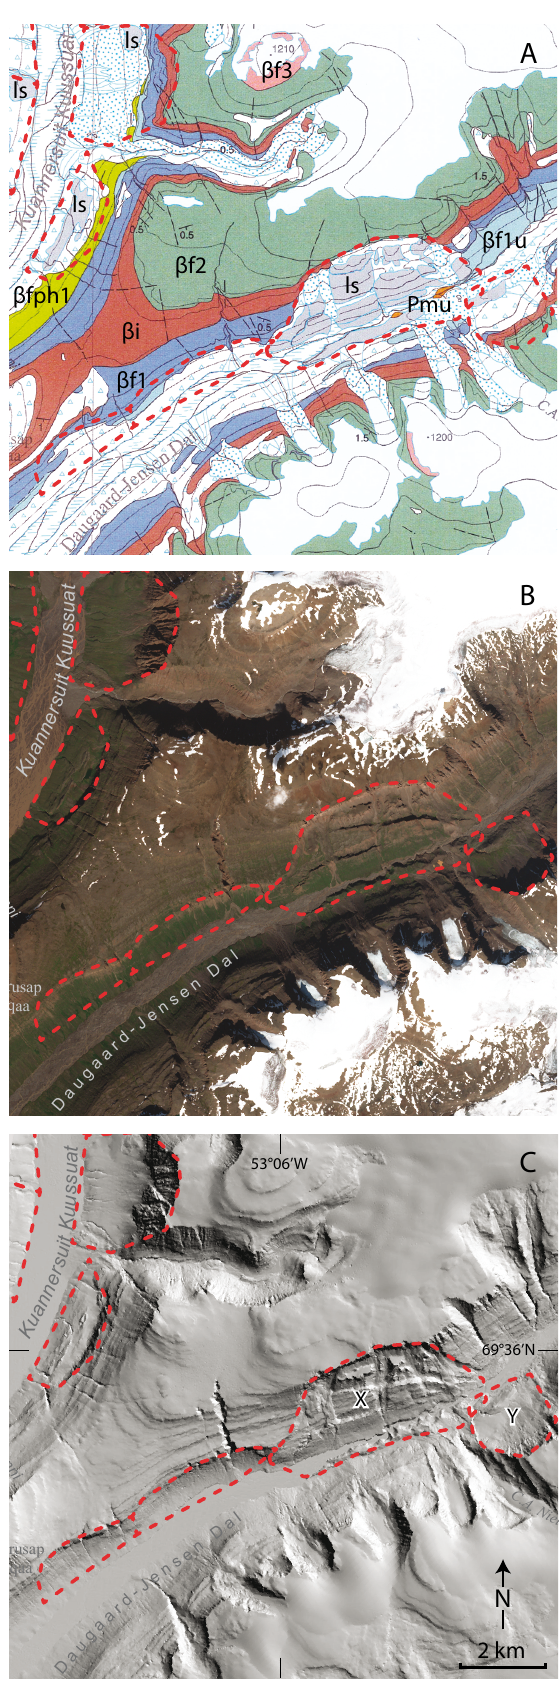
Fig. 2. Three spatial datasets of the same area in Daugaard-Jensen Dal, central Qeqertarsuaq (Disko), West Greenland. See Fig. 1 for location. Mapped landslides are outlined by red dashed lines. A : Extract from the 1:100 000-scale geological map (Pedersen et al. 2001). Landslide depos- its ( ls ) are greyish purple, basalt members of the Maligât Formation are light green ( βfph1 ), blue ( βf1 ), light blue ( βf1u ), brown ( β i ), dark green ( βf2 ) and pink ( βf3 ). At the base of the central landslide deposit, Paleo- cene mudstones ( Pmu ) of the Atanikerluk Formation are exposed. These may have provided the failure surface for the central landslide as is also suggested for the 2000 Paatuut landslide 80 km to the north (Pedersen et al. 2002; Dahl-Jensen et al. 2004). B : Sentinel-2A satellite image from 8 August 2018. C : Hillshade from ArcticDEM (Porter et al. 2018) of the area illuminated from the north-east. What appears to be a single land- slide deposit in the geological map (A) is actually, on closer inspection of the Arctic DEM (C), two landslides: A large slide on the south-facing slope with well-defined rotated blocks, here called the Daugaard-Jensen Dal landslide ( X ), and a smaller slide to the east on the north-facing slope ( Y ). West of the Daugaard-Jensen Dal landslide are two smaller arcuate head scarps with no landslide deposits; such deposits may be buried under the deposits of the braided river. To the east of this feature, the river has incised the toe of the Daugaard-Jensen Dal landslide by up to 80 m. In the Kuannersuit Kuussuat valley to the north-west, several large landslides were also